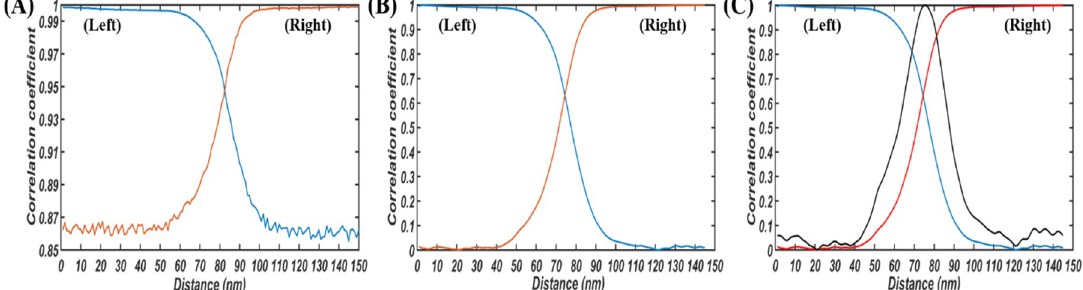
Figure 2. Correlation coefficient profiles at the accelerating voltage of 30 kV and thickness of 91 nm ( A ) determined by using the digital image correlation (DIC) technique by comparing the sampling patterns with the left (blue curve) and right patterns (red curve) in order and ( B ) after average filtering. ( C ) Sum of the normalized correlation coefficients as a function of the distance.